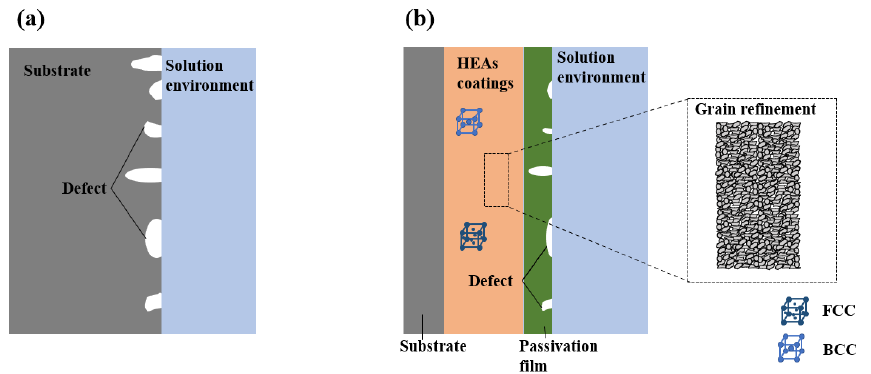
Figure 5. Schematic representation of corrosion resistance mechanism: ( a ) bare substrate; ( b ) LC- HEACs.